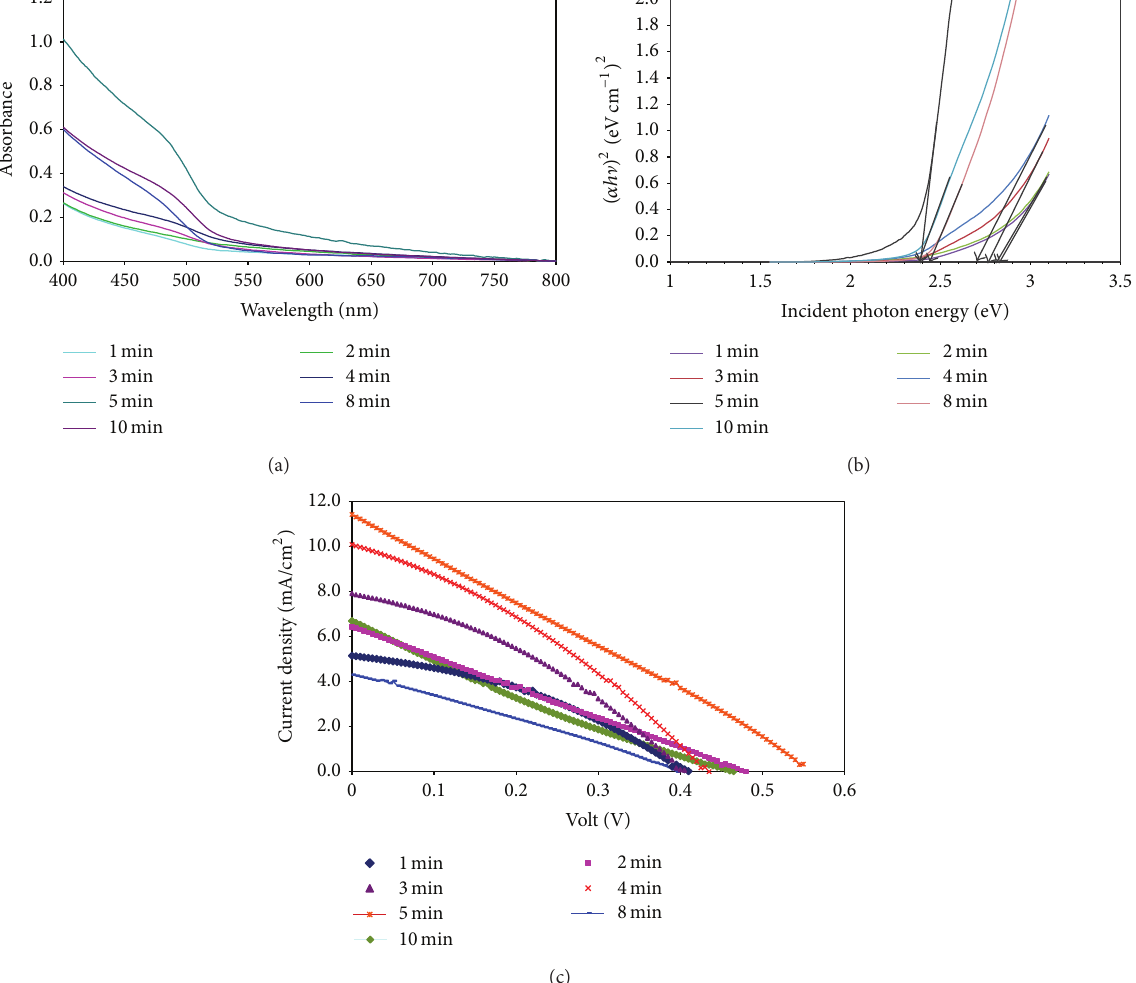
is the dipping time in each solution. This parameter goes hand in hand with the number of dipping cycles as longer dipping time would require lesser number of dipping cycles and vice versa. However, the quantity and quality of QDs may vary depending on the dipping time and the number of dipping cycles. The optimum numbers of dipping cycles as determined in Section 3.3 were used for the preparation of CdS and CdSe QDs in this